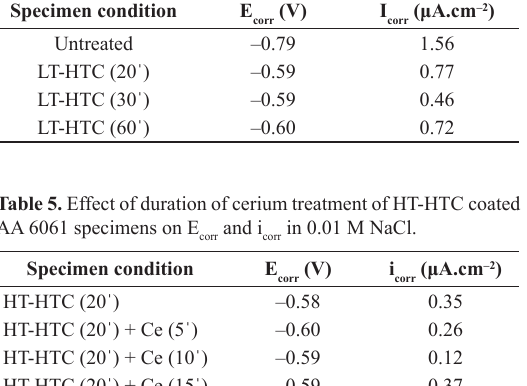
Table 6. Effect of duration of cerium treatment of LT-HTC coated AA 6061 specimens on E Specimen